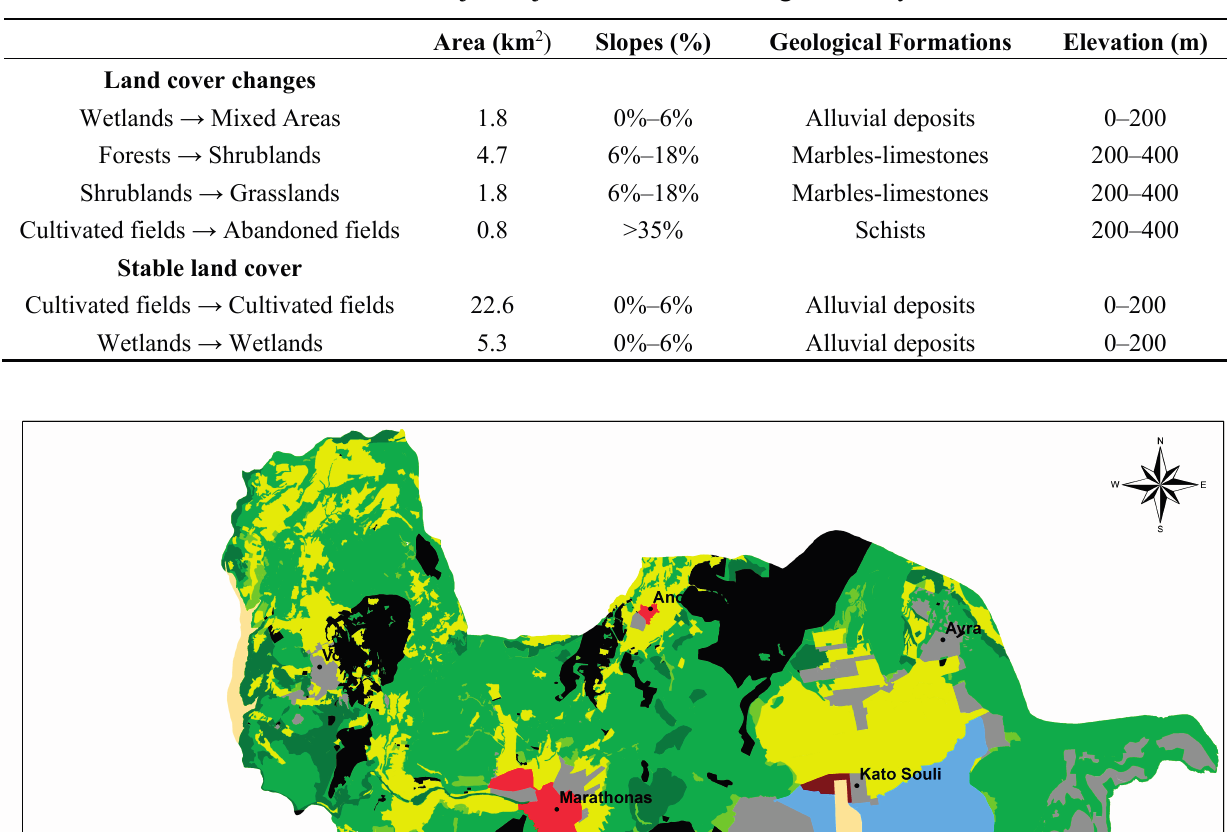
Table 5. Major trajectories of LC change/stability.